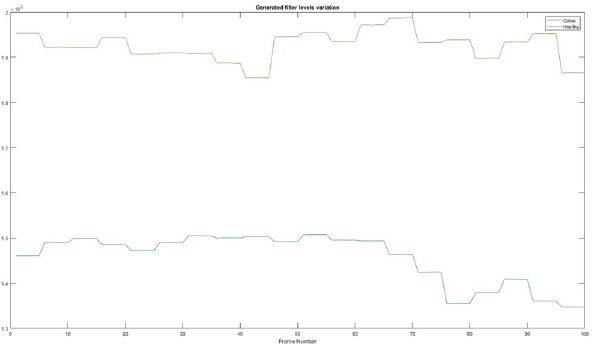
Figure 18. The values obtained after applying the generated filter. Red = Healthy and Blue = Celiac.